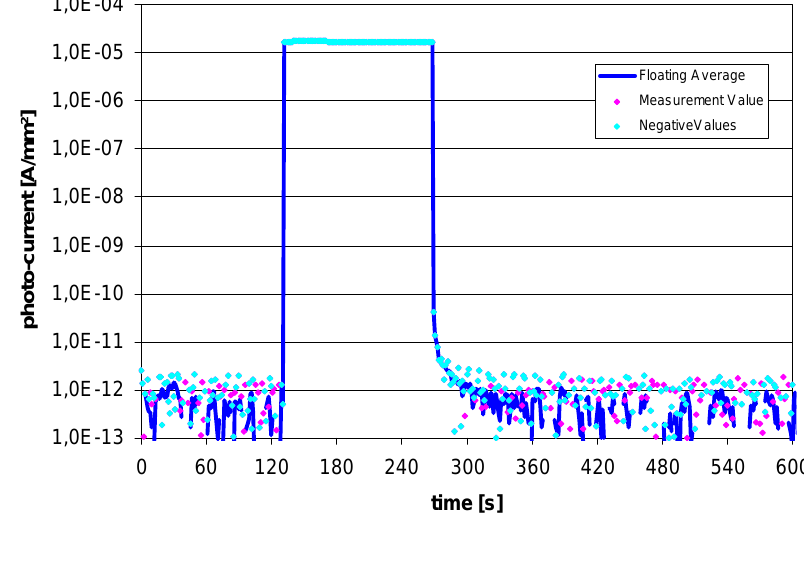
Figure 11. Rise- and fall time of the 1.5 µm thick TFC